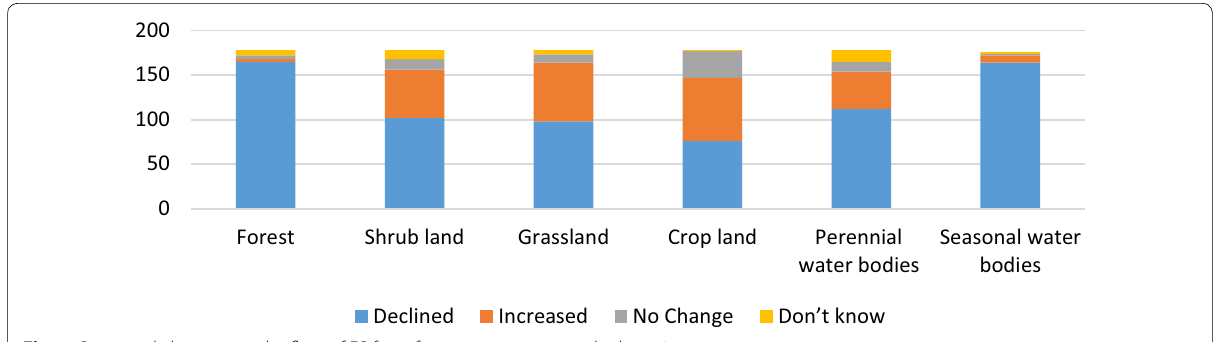
Fig. 5 Perceived changes on the flow of ES from four ecosystems over the last 10